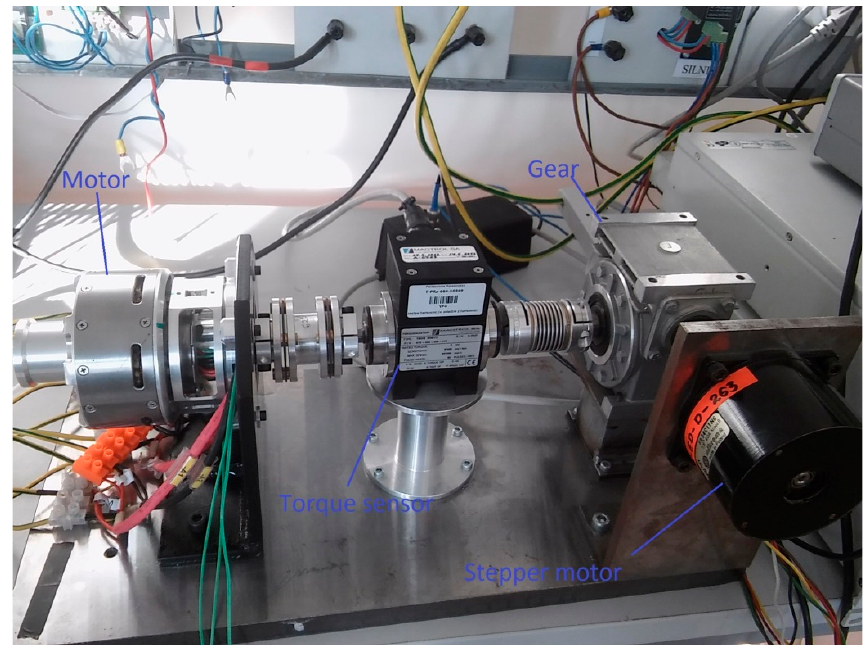
Figure 4. Stand for measurement of static characteristics.